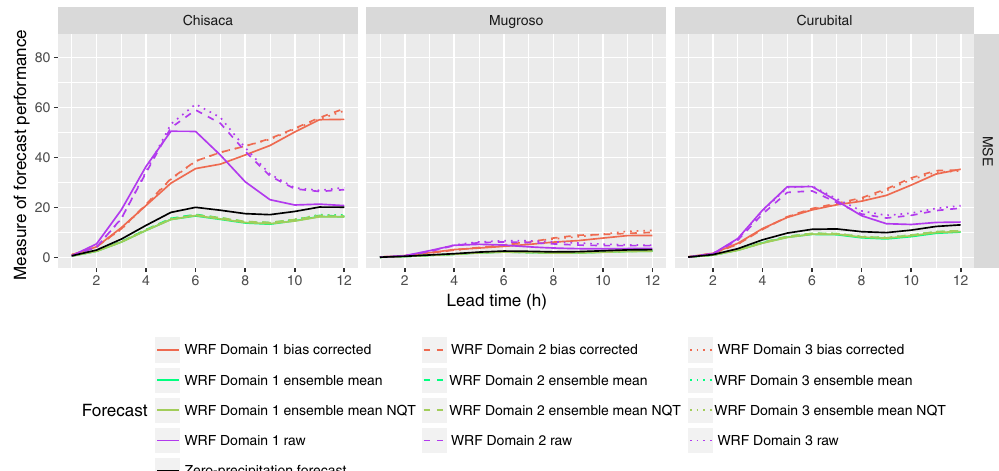
Figure 8. Performance measures for deterministic discharge and ensemble mean forecasts obtained excluding the storm with the highest precipitation missed by the WRF model. Domain 1, domain 2 and domain 3 correspond respectively to the domains with resolutions 15, 5 and 1.67km. The legend is the same as in Fig. 7.